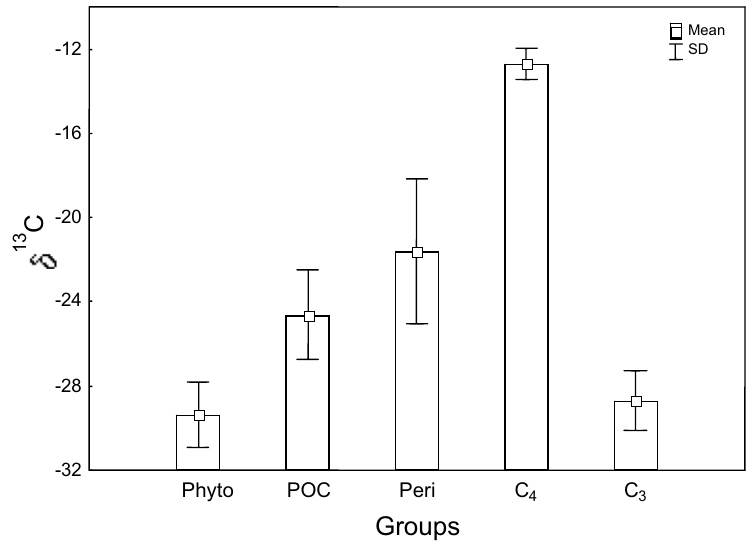
Fig. 2 – Means Values and standard deviation (SD) of δ 13 C for C 3 plants, C 4 grasses, phytoplankton (phyto), periphyton (peri) and POC (Particulate Organic Carbon) sampled in the area of influence of Corumbá Reservoir (source: Benedito-Cecilio et al.